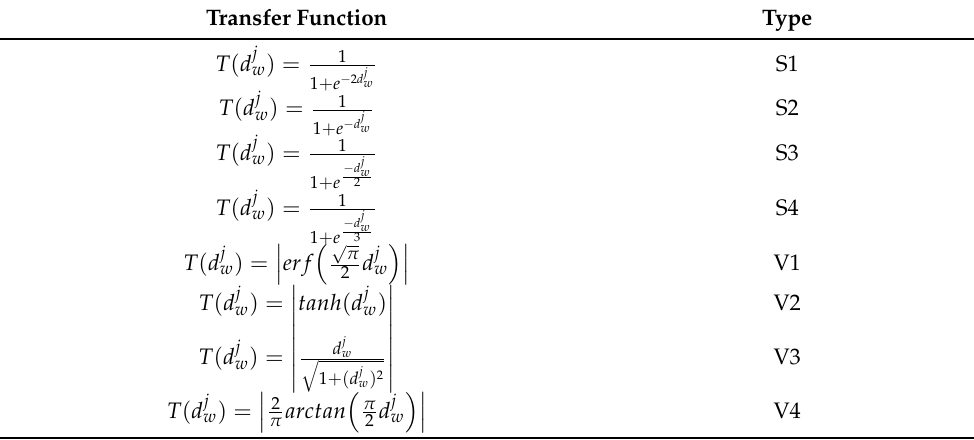
Table 1. Transfer functions